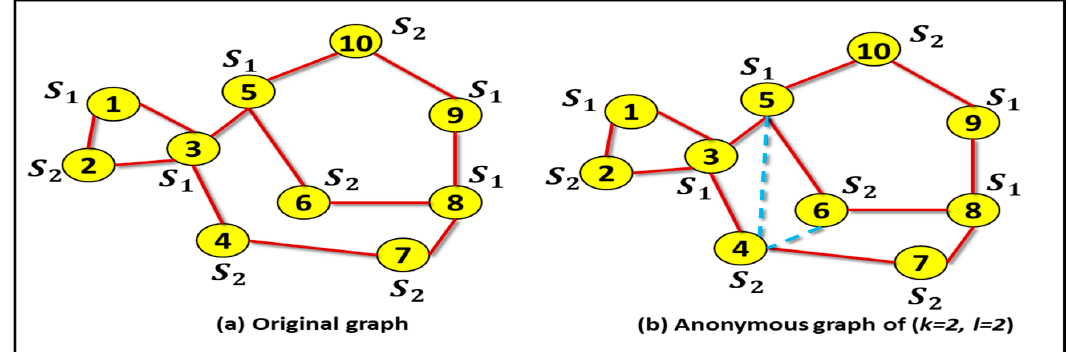
Figure 42. Example of the l -diverse and k -anonymous graph (where both k = 2 and l = 2